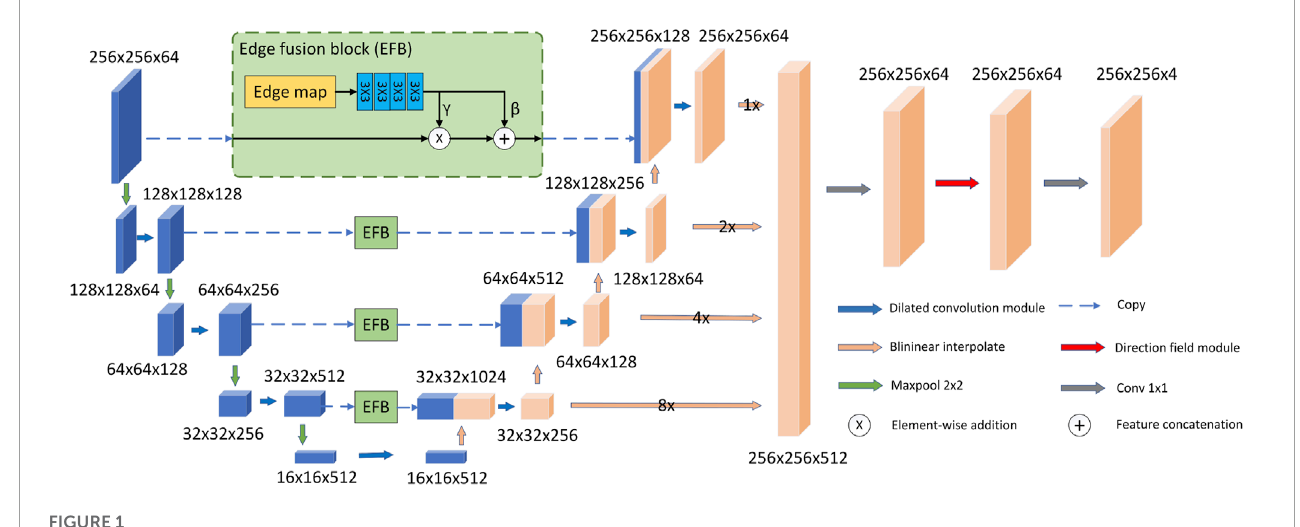
FIGURE 1 Overall structure of the proposed DDFN model.